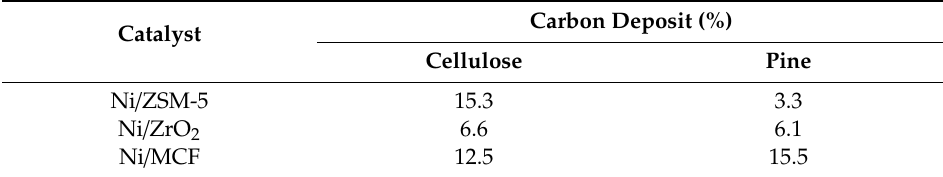
Table 5. Content of carbon deposit calculated on the basis of thermogravimetric analysis / di ff erential thermal analysis (TGA / DTA)